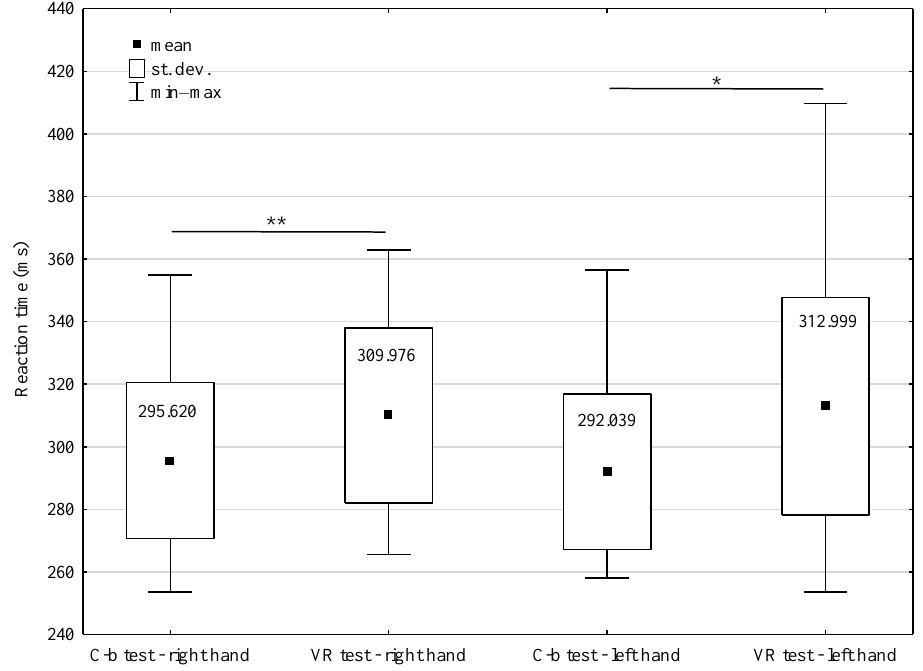
Figure 9. Simple RT of MMA fighters during the tests in VR and computer-based (C-b) tests, * p < 0.05, ** p <